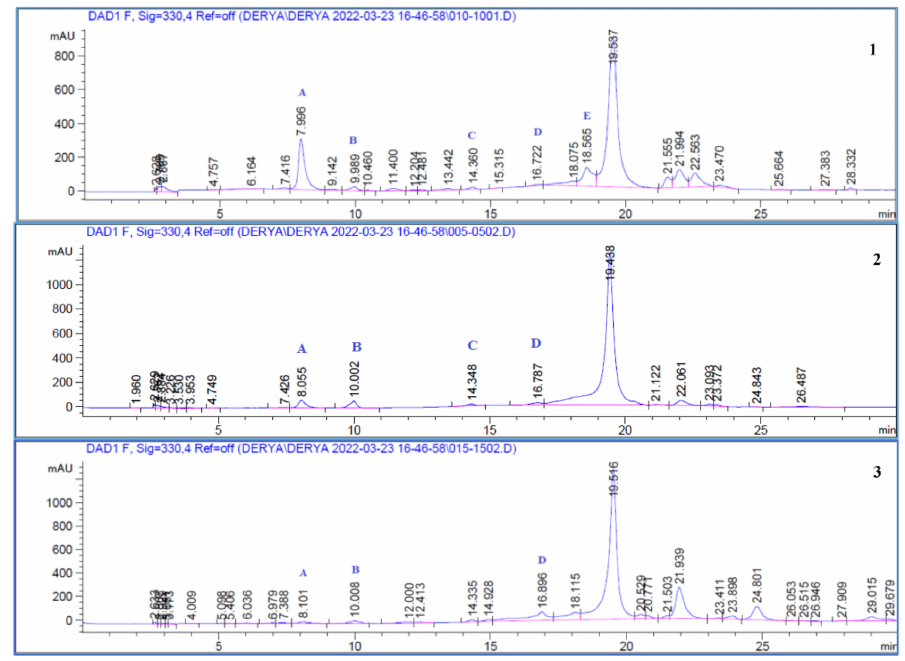
Figure 2. HPLC chromatograms of ethyl acetate fractions of Arctium minus extracts: 1 . Ethyl acetate fractions of leaves, 2 . ethyl acetate fractions of flower heads, 3 . ethyl acetate fractions of roots. Peaks: A —Chlorogenic acid, B —Caffeic acid, C —Coumaric acid, D —Ferulic acid, and E